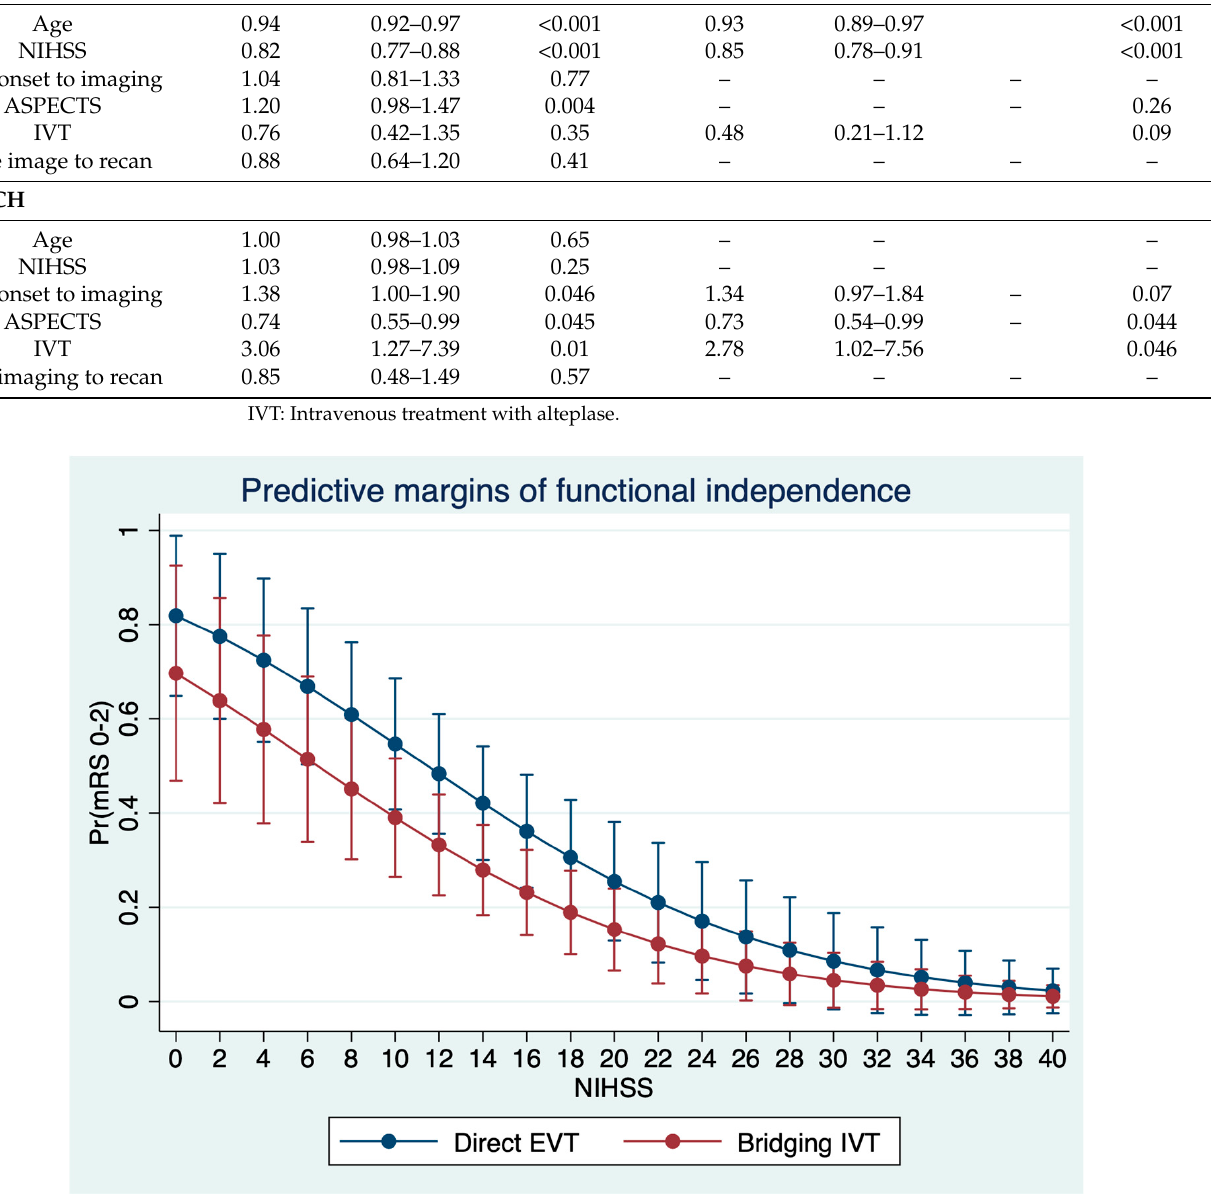
Figure 2. Prediction of functional independence ( y axis) based on multivariable logistic regression analysis to show the impact of IVT application according to the baseline NIHSS adjusted for age and ASPECTS (Table